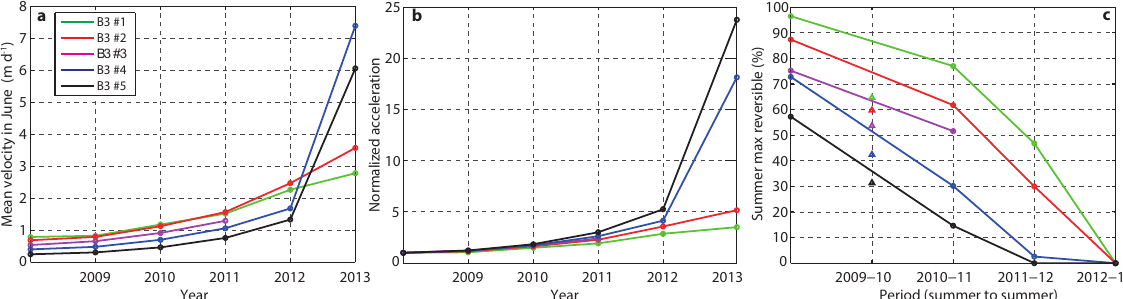
Figure D1. GPS-velocity evolution along a central flowline of Basin-3: (a) annual velocity minimum defined as the mean value in June 2008 to 2013 and (b) normalized to mean June velocity 2008, and (c) reversibility of summer speed-up defined as the ratio of the velocity increase from pre-summer minimum (mean June) to maximum summer velocity and subsequent velocity decrease to pre-summer velocity of the subsequent year. In 2009, summer maximum velocities were not captured due to GPS power loss. The triangles only indicate a minimum estimate for 2009–2010, based on elevated late-summer velocities measured after maintenance of GPS receivers at the end of